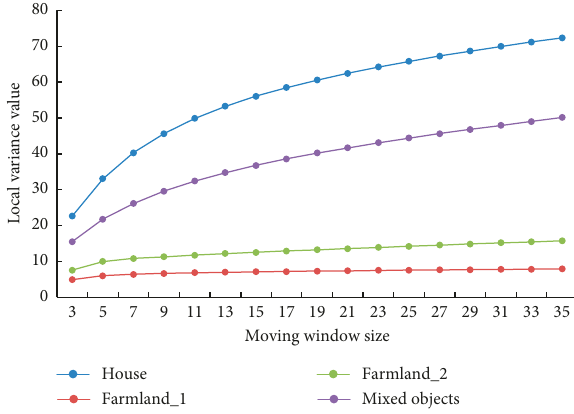
Figure 11: Local variance curve of four different subset textures. Table 2: Optimal scale selected by different